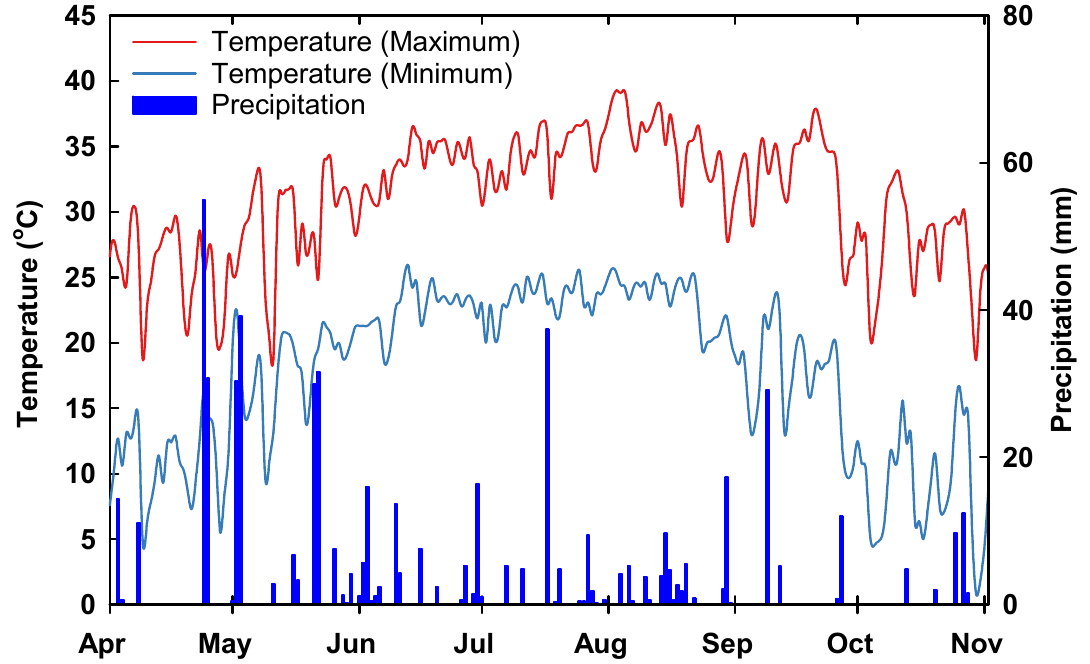
Figure 1. Daily weather parameters (temperature and rainfall) during crop growing season. Data were obtained from the PRISM weather data ( http://www.prism.oregonstate.edu ) for the experiment site.